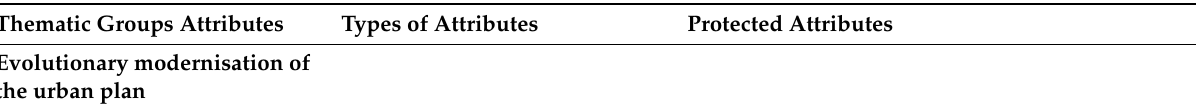
Table 7. Attributes that illustrate evolutionary modernisation of the urban